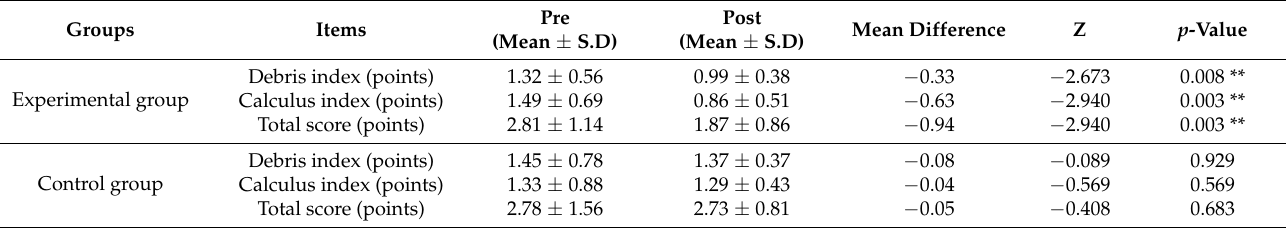
Table 5. The results of oral hygiene within a group.